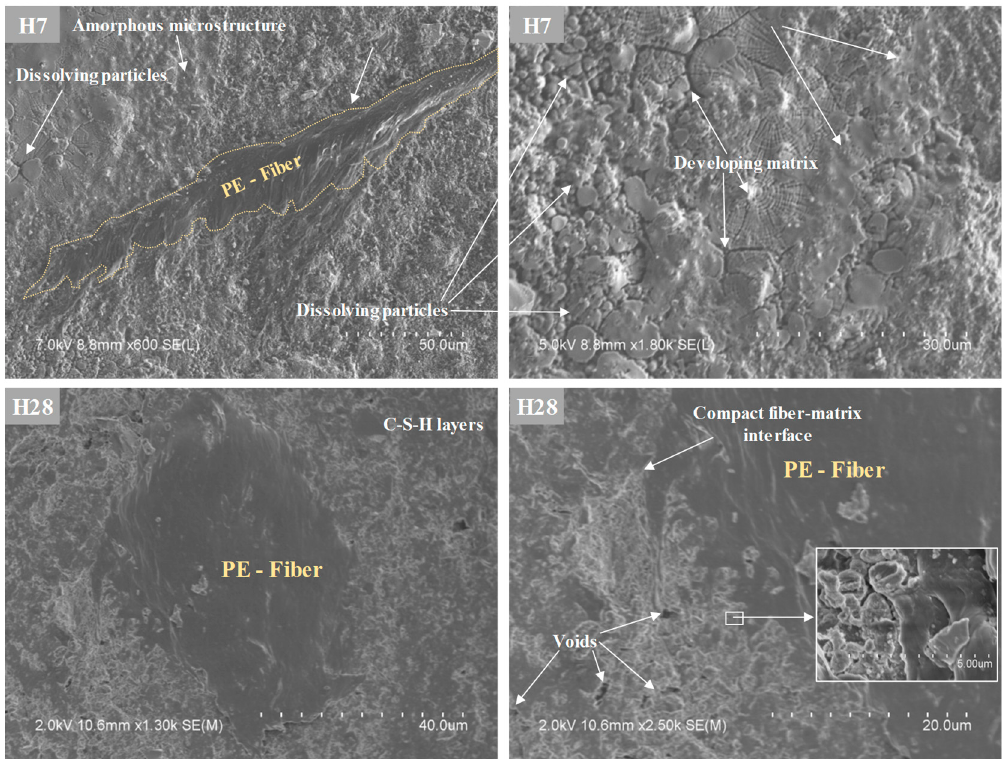
Figure 8. SEM images on the microstructure of specimens H7 and H28.